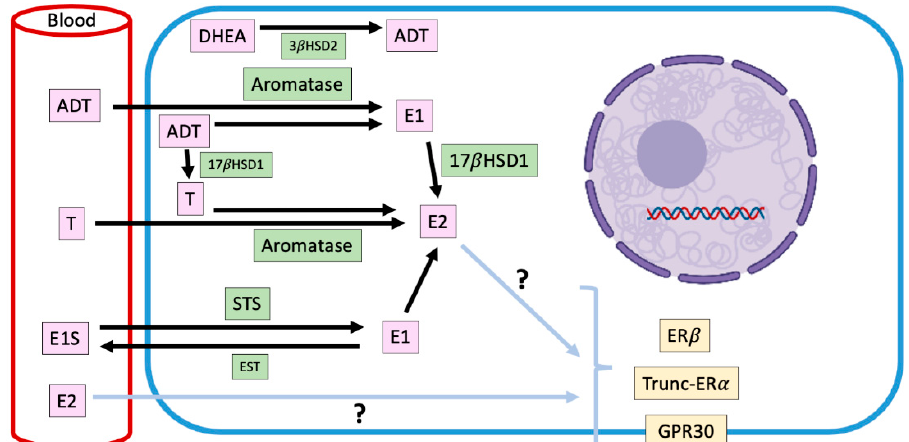
Figure 2. Representation of intracrine estradiol synthesis and its main precursors in ER α -negative canine mammary tumors. Mammary estradiol production in ER α -negative canine mammary tumors, where the responsible steroidogenic enzymes, their substrates and products, and the receptors that could mediate its pro-carcinogenic effects are shown. E2: